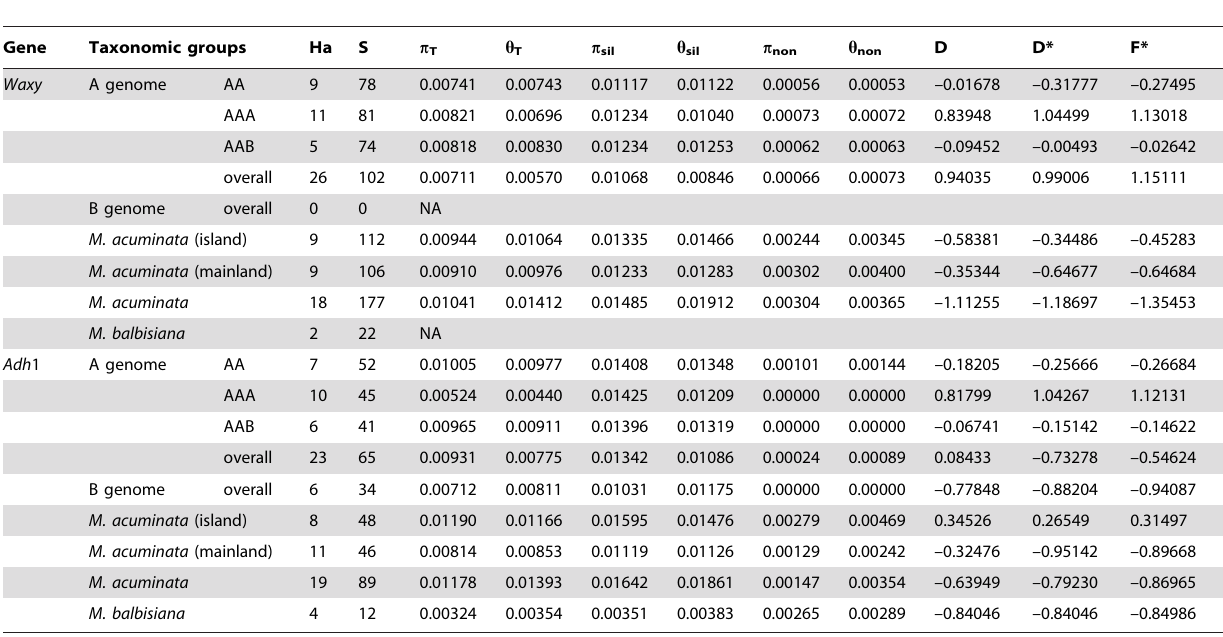
Table 2. Summary of nucleotide diversity and neutrality test statistics for Waxy and Adh 1 genes.